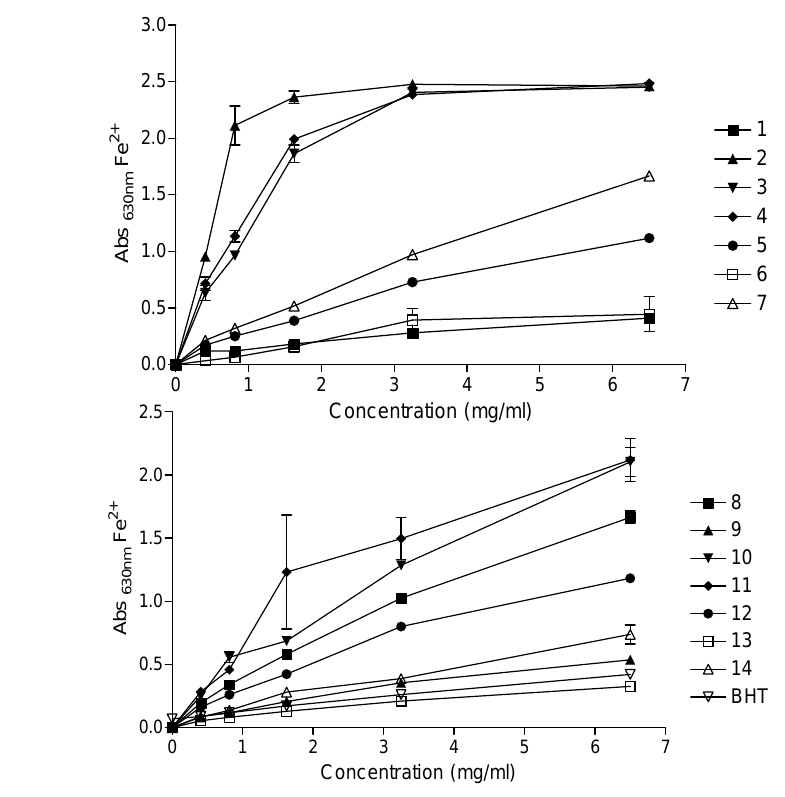
Figure 1. Ferric reducing activity of commercial herbal preparations (A; 1-7 and B; 8-14); BHT- butylated hydroxytoulene. Increase in absorbance of the reaction mixture indicates the increase in reducing power. Refer to Table 1 for the corresponding names of preparations